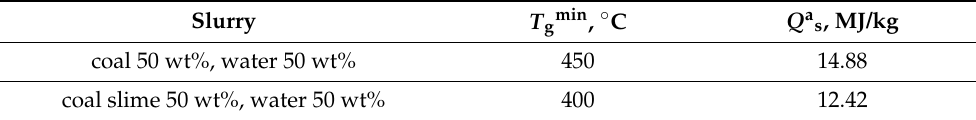
Table 4. Minimum ignition temperatures and calorific value of coal–water slurry